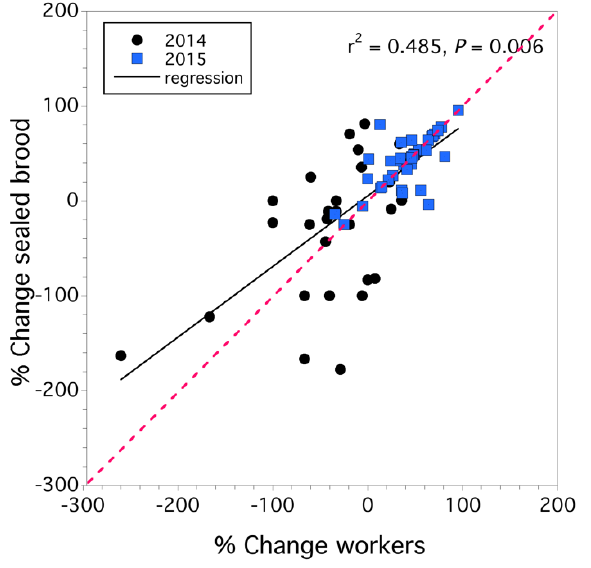
Figure 2. Linear relationship between percentage rate of worker colony strength and percent rate of change in sealed brood colony strength. Red dashed line is 1:1 slope. Table 1. Pesticide residues in highest average concentrations (ppb/location) in trapped pollen, wax comb, and bee bread, in 2014 and